Question: In a single sentence, describe what this figure presents.
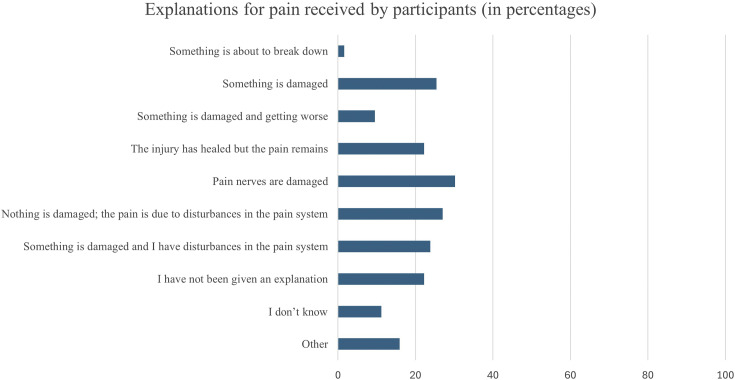
Answer: Explanations for pain received by participants (in percentages). Note. Multiple responses allowed.